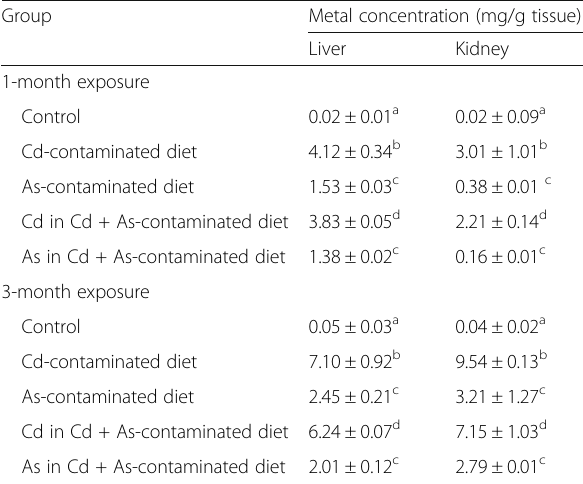
Table 3 Effect of food chain-mediated exposure to Cd and As on metal accumulation in the organs of